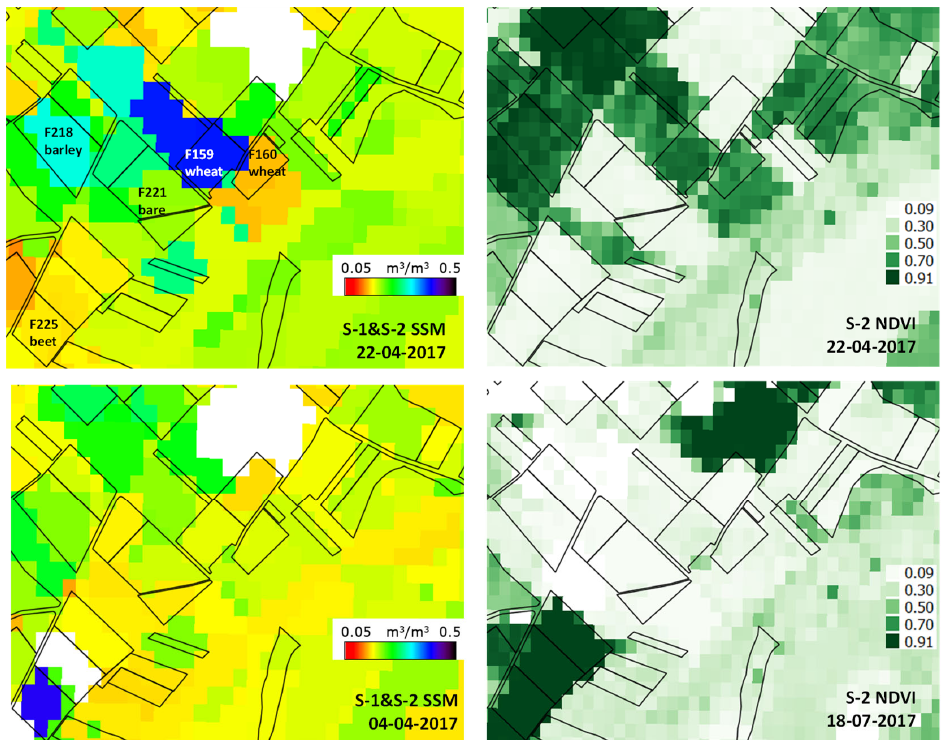
Figure 5. View over the Riaza irrigation district in Spain. Parcel borders are in black. Left column : SSM maps at field scale, derived on 22 and 4 April 2017. White areas are fields masked for tillage practice. The irrigated fields, f159, f218 and f225, show medium–high (i.e., 0.3–0.4 m 3 /m 3 ) SSM levels. Right column : NDVI maps on 22 April and 18 July 2017.